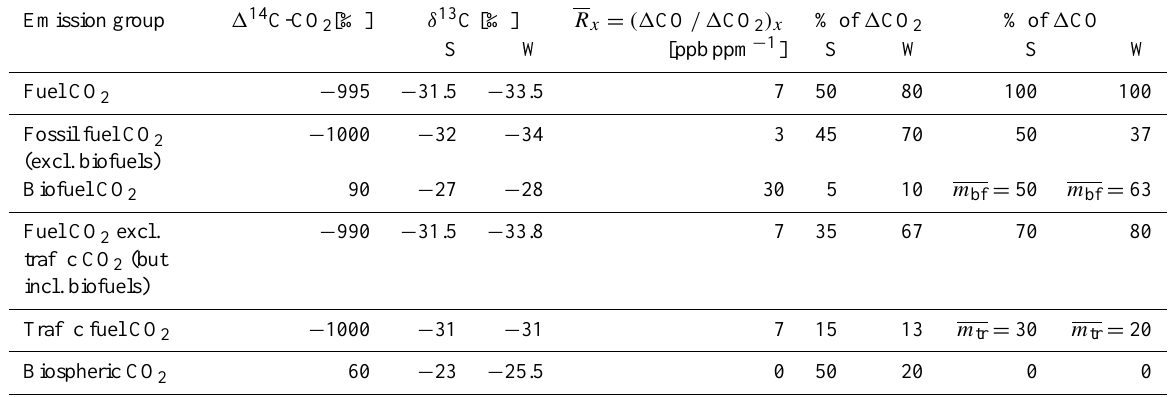
Table A1. Annual or half-yearly (summer: S; winter: W) averaged (cid:49) 14 C(CO 2 ) , δ 13 C(CO 2 ) , (cid:49) CO /(cid:49) CO 2 ratios, and mean fraction of CO 2 and CO relative to total CO 2 and CO offsets as used in our model study for the measurement site Heidelberg for the year 2012. Biosphere (cid:49) 14 C(CO 2 ) values are based on Taylor et al. (2015). The (cid:49) CO /(cid:49) CO 2 ratio and the fractions of CO 2 and CO offset were taken from the STILT model runs, which were fed with anthropogenic emissions from the EDGAR emission inventory. Note that fractions of biofuels in traffic CO 2 emissions are not included. δ values were derived by assigning an isotopic value to each fuel type and weighting these depending on the respective share of the fuel type to total fuel CO 2 at the measurement site. The δ values of the biosphere are the half-yearly mean values from Table 1. Analogously, R x (and (cid:49) 14 C x ) values were derived by assigning an emission ratio CO / CO 2 (and (cid:49) 14 C(CO 2 ) value) to each emission sector and weighting these depending on the respective share of the emission sector to total fuel CO 2 at the site. Emission